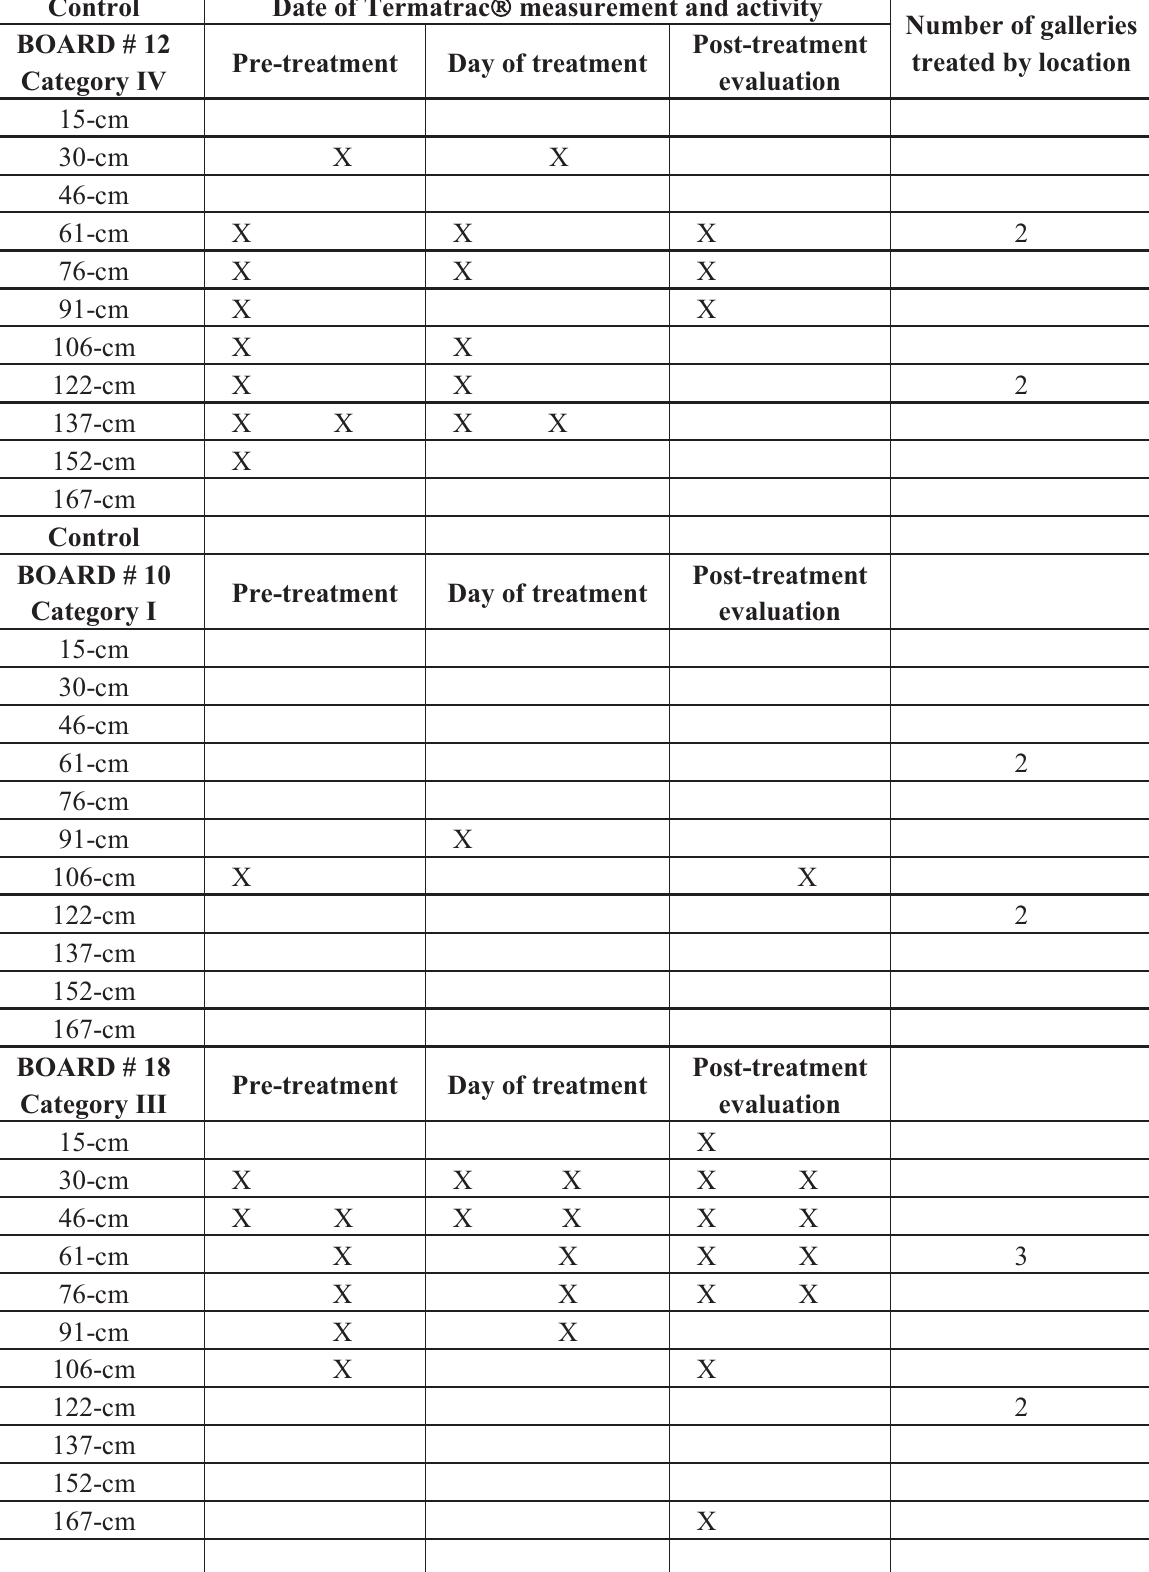
Table 5. Table illustrative of the relative position (left or right-side of board), by board section and date, of termite activity as measured using the Termatrac (cid:2) listed by treatment including pre-treatment activity category of the board and the number of galleries identified for treatment by position for each board as measured using the